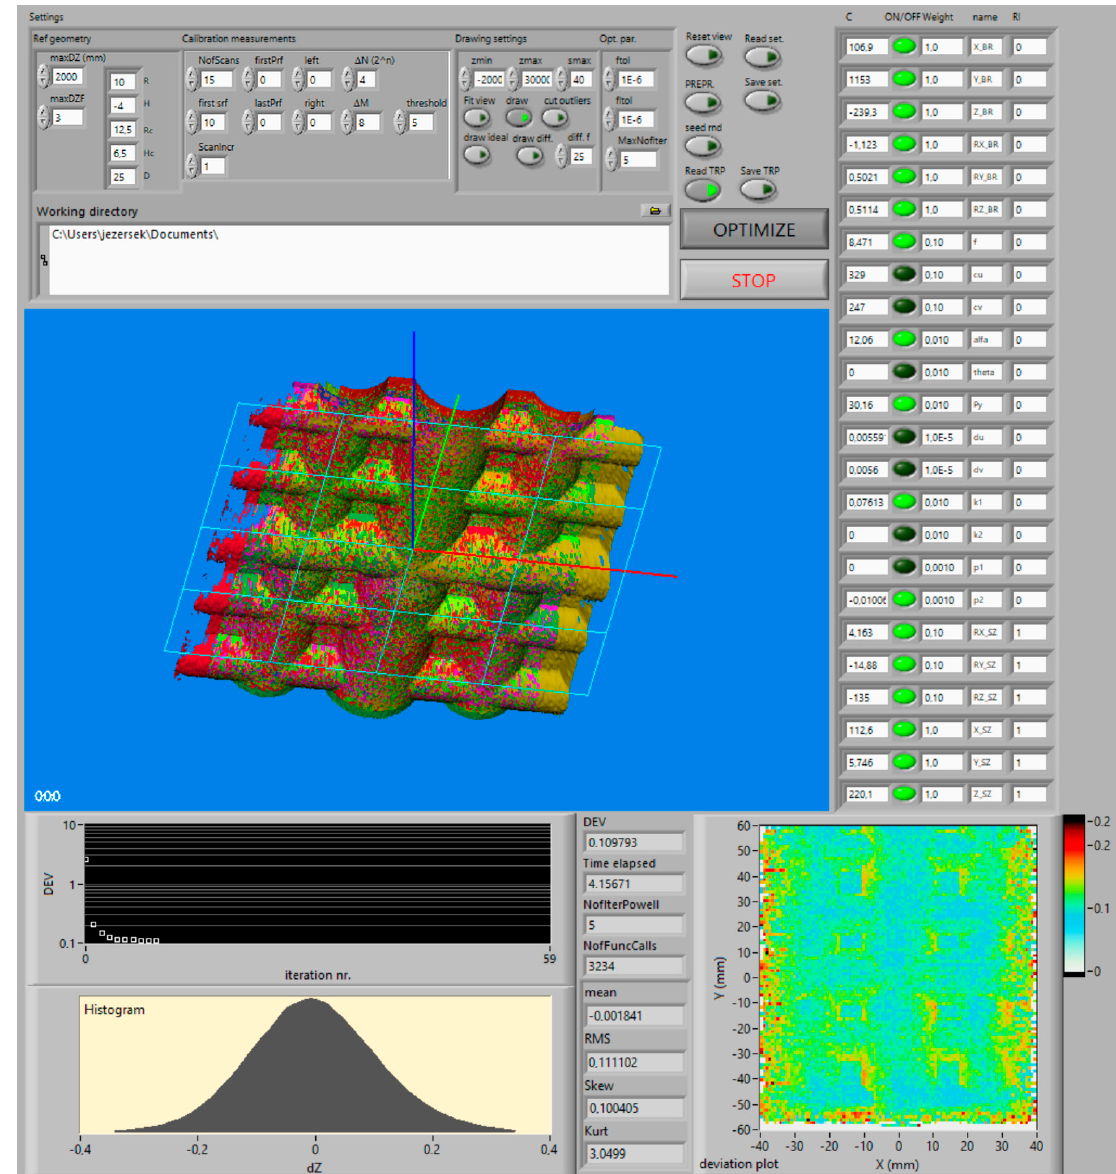
Figure 8. Graphical user interface of the calibration program.